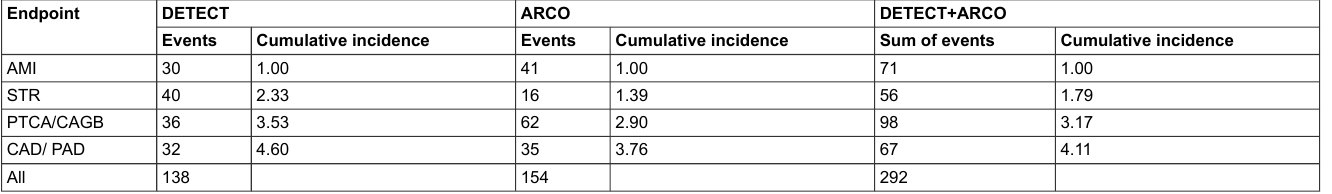
Table 9: Incidence of cardiovascular endpoints in DETECT [8] (n = 4044) and ARCO (n = 2842) and combination of both studies with 34,340 observed patient years (29 transient is- chaemic attacks from DETECT were excluded from this analysis). Endpoint DETECT